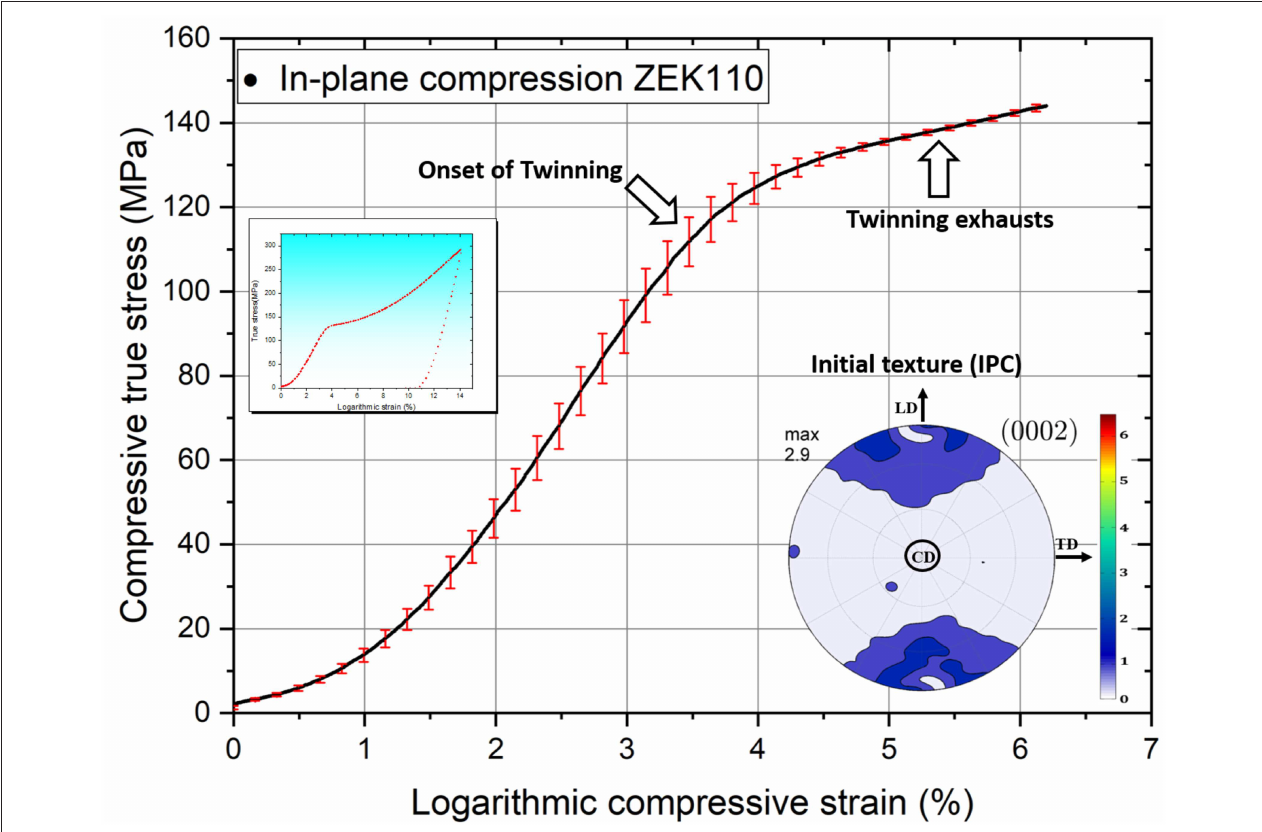
FIGURE 1 | Flow curves during in-plane compression of Mg-1wt.%Zn-1wt.%Gd-0.6wt.%Zr (ZEK110) alloy. White arrows indicate the onset of twinning and the strain at which twinning exhausts. Inset image on the lower right showing the starting texture of the specimen. Error bars indicate the stress variation across flow curves recorded for six independent deformation